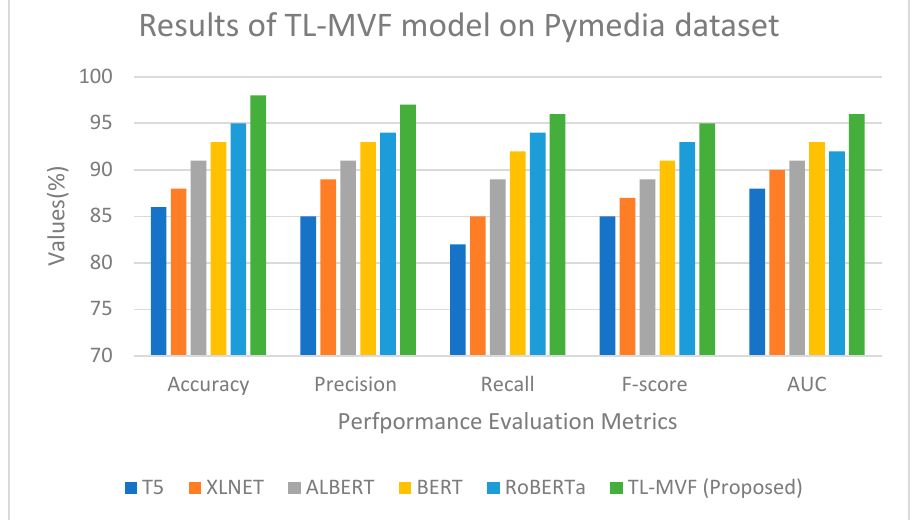
Figure 10. Comparative result analysis of the TL-MVF model with existing benchmarked models over the Pymedia dataset.